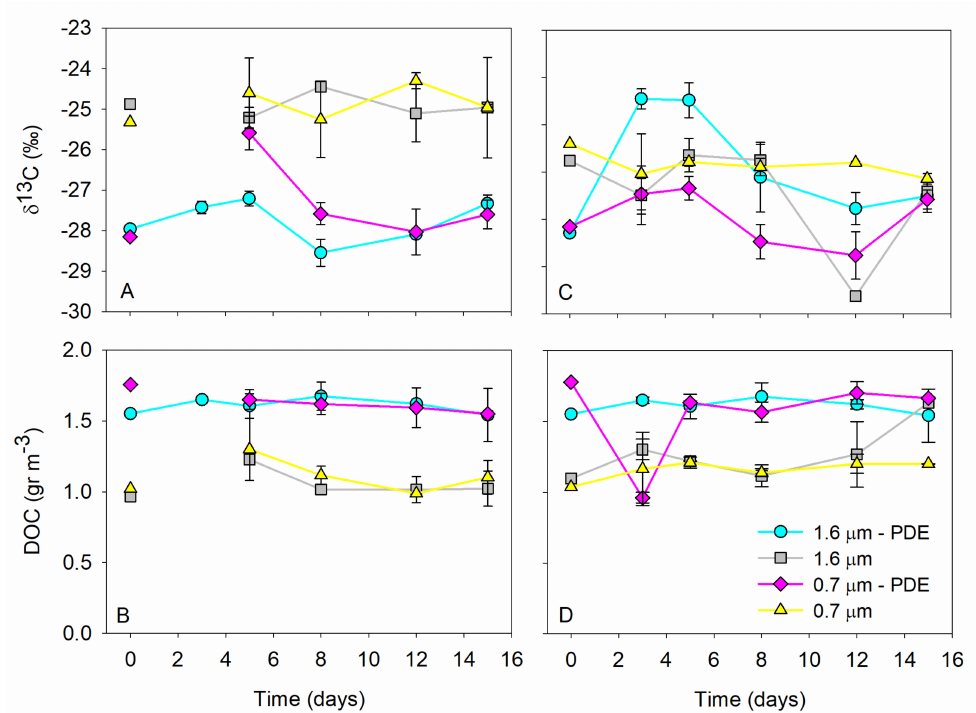
Figure 3. δ 13 C (‰) ( A , C ) and DOC concentration (gr m − 3 ) ( B , D ) from the different treatments, with PDE addition and control, and for the different bacterioplankton. Left panel corresponds to marine station 5 and the right panel to estuarine station